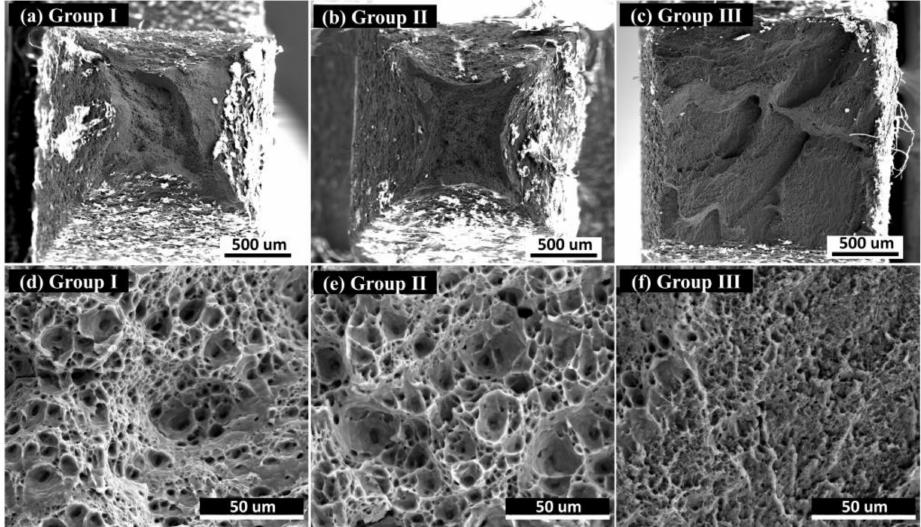
Figure 10. The SEM images showing the fracture surface morphology of dog-bone samples after tensile tests. ( a , d ) Group I, ( b , e ) Group II, ( c , f ) Group